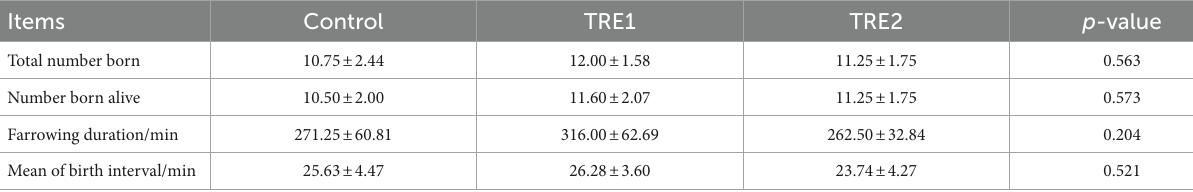
TABLE 2 Effects of feeding bamboo powder on the farrow duration of sows. Items